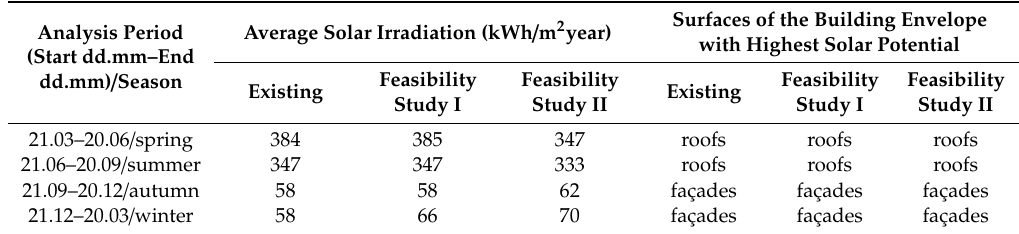
Table 12. Seasonal irradiation analyses in the existing situation and in the feasibility studies. Analysis Period (Start